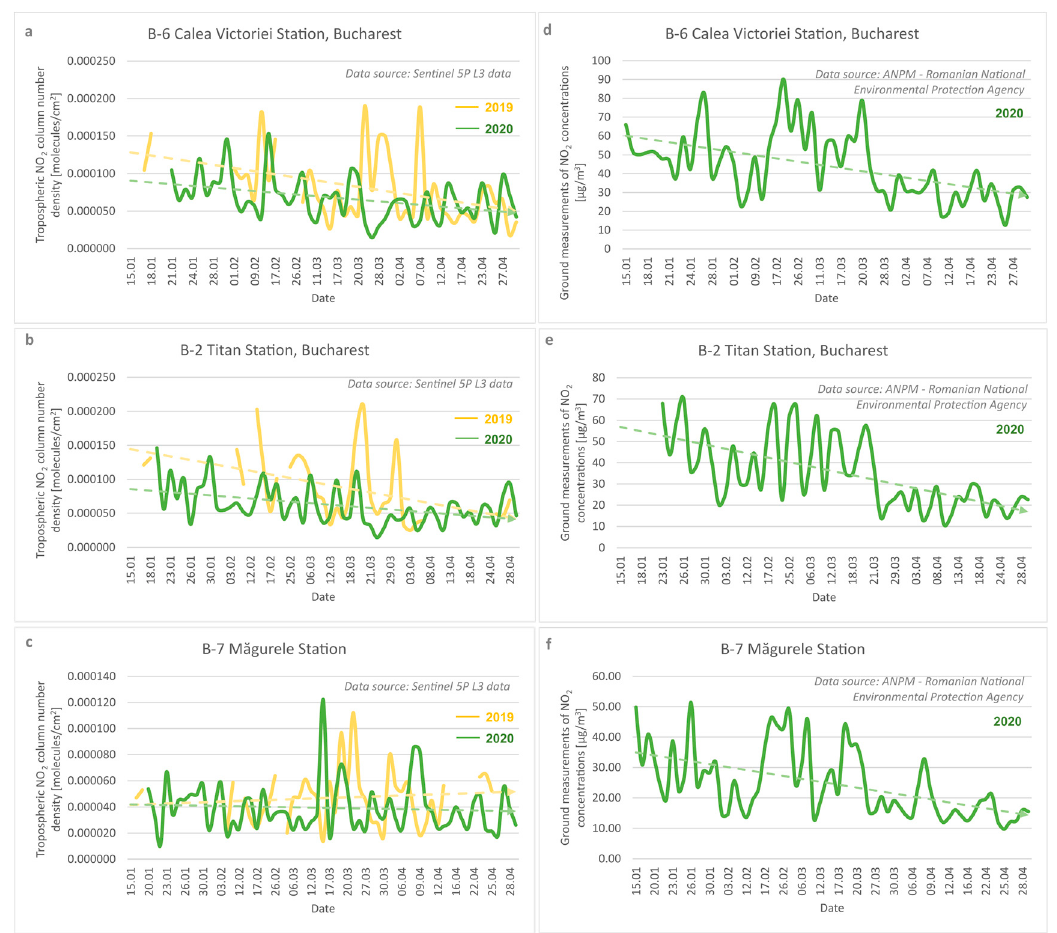
Figure 9. Comparative dynamics of NO 2 daily values for the periods between 15 January and 30 April, for different locations from Bucharest (Romania), based on TROPOMI data from 2019 and 2020 ( a – c ) and ground-based measurements from 2020 ( d – f ).